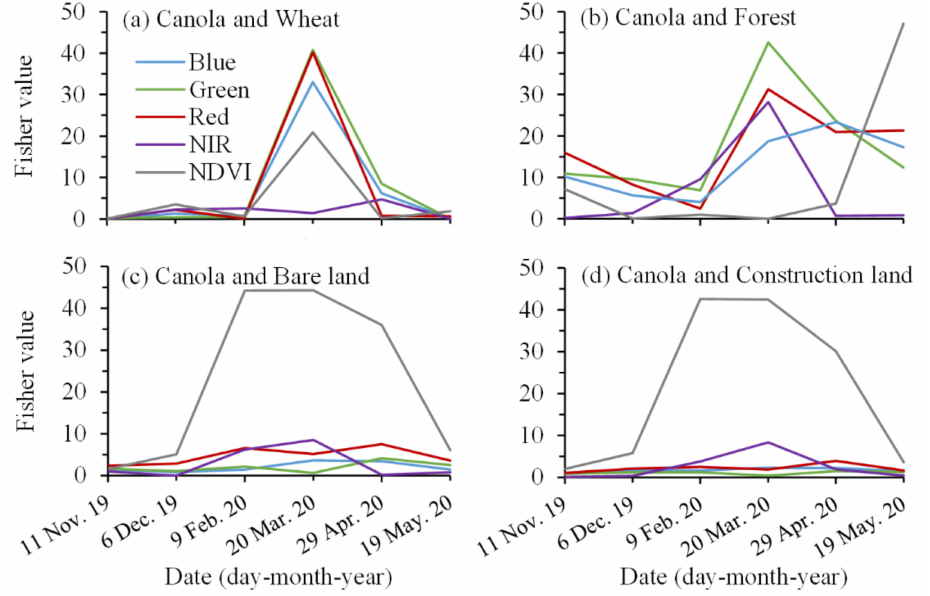
Figure 5. Fisher values ( a ) between canola and wheat, ( b ) between canola and forest, ( c ) between canola and bare land, and ( d ) between canola and construction land in different spectral bands